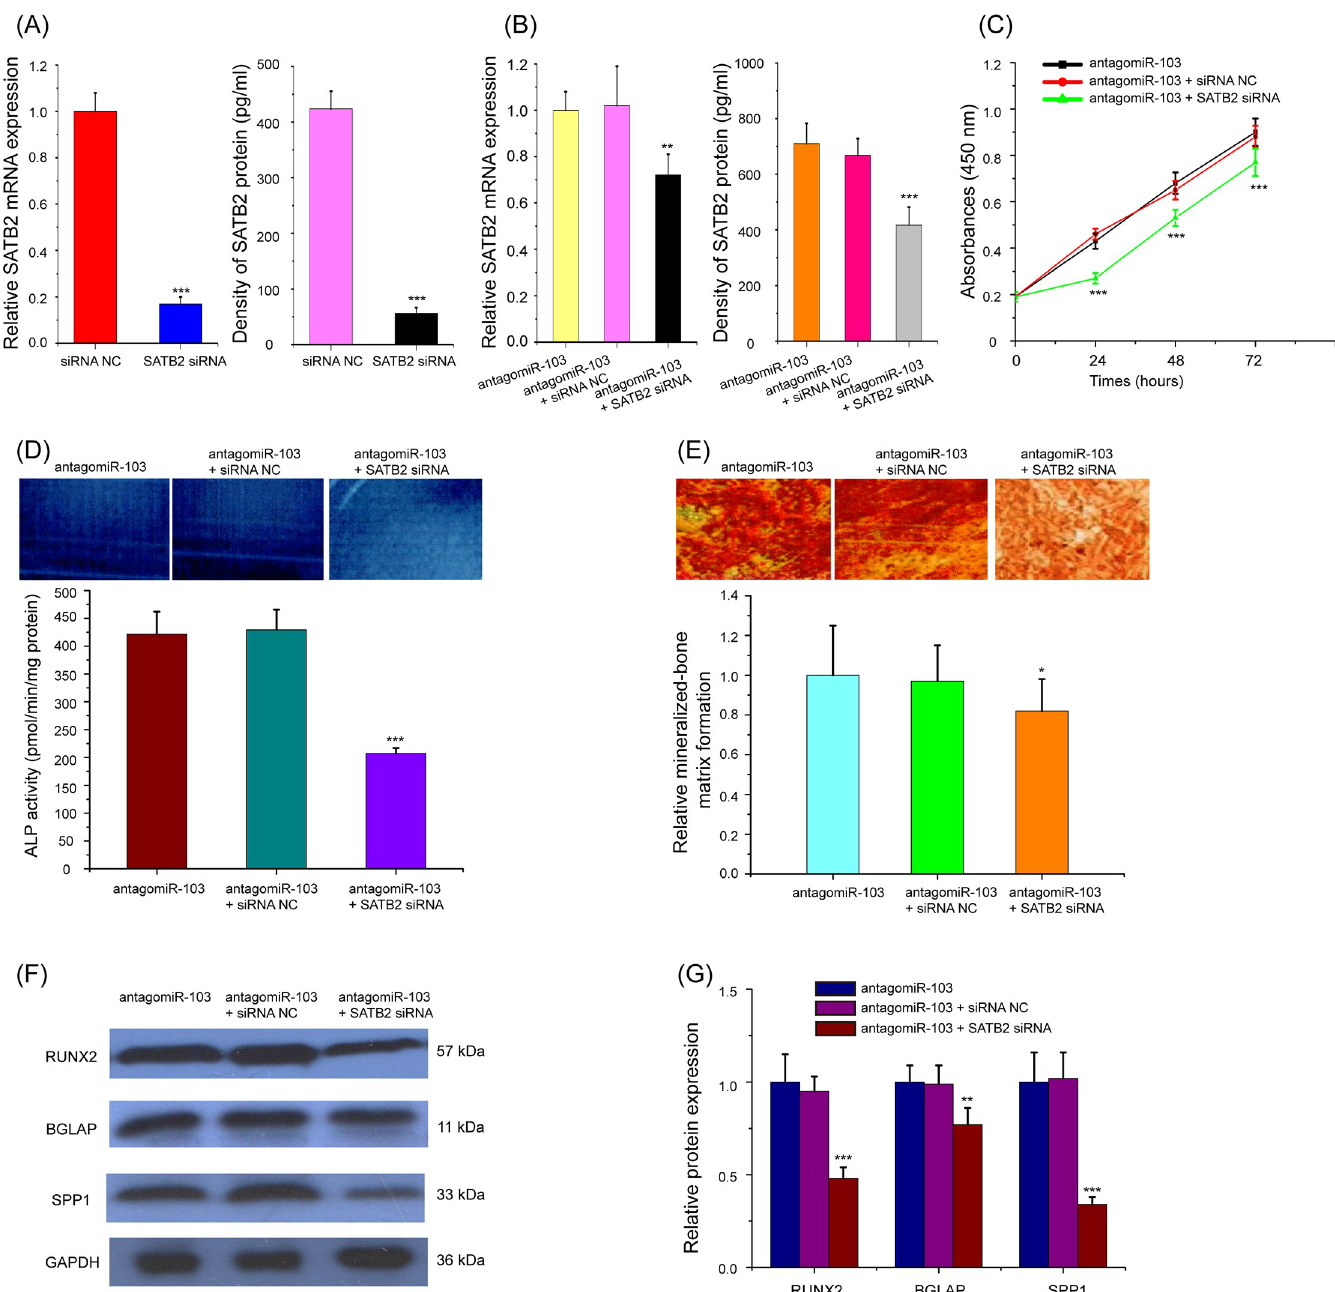
Fig 5. miR-103 participates in the proliferation and osteogenic differentiation of HBMScs by directly targeting SATB2 . (A) Expression levels of SATB2 mRNA and protein were examined after transfection of SATB2 siRNA and siRNA NC. (B) Transfection of SATB2 siRNA partly reversed the upregulation of SATB2 expression by antagomiR-103. (C) HBMScs co-transfected with antagomiR-103 and SATB2 siRNA exhibited a lower cell proliferation ability than cells transfected with antagomiR- 103 and siRNA NC. (D) SATB2 knockdown partly abolished antagomiR-103 induced ALP activity of HBMScs. (E) SATB2 knockdown partly abolished antagomiR-103 induced mineralized matrix formation of HBMScs. (F and G) HBMScs treatment with antagomiR-103 and SATB2 siRNA reduced the protein expression levels of RUNX2, BGLAP, and SPP1 compared cells treated with antagomiR-103 and siRNA NC. Columns mean of three independent experiments. � p < 0.05, �� p < 0.01, ��� p <